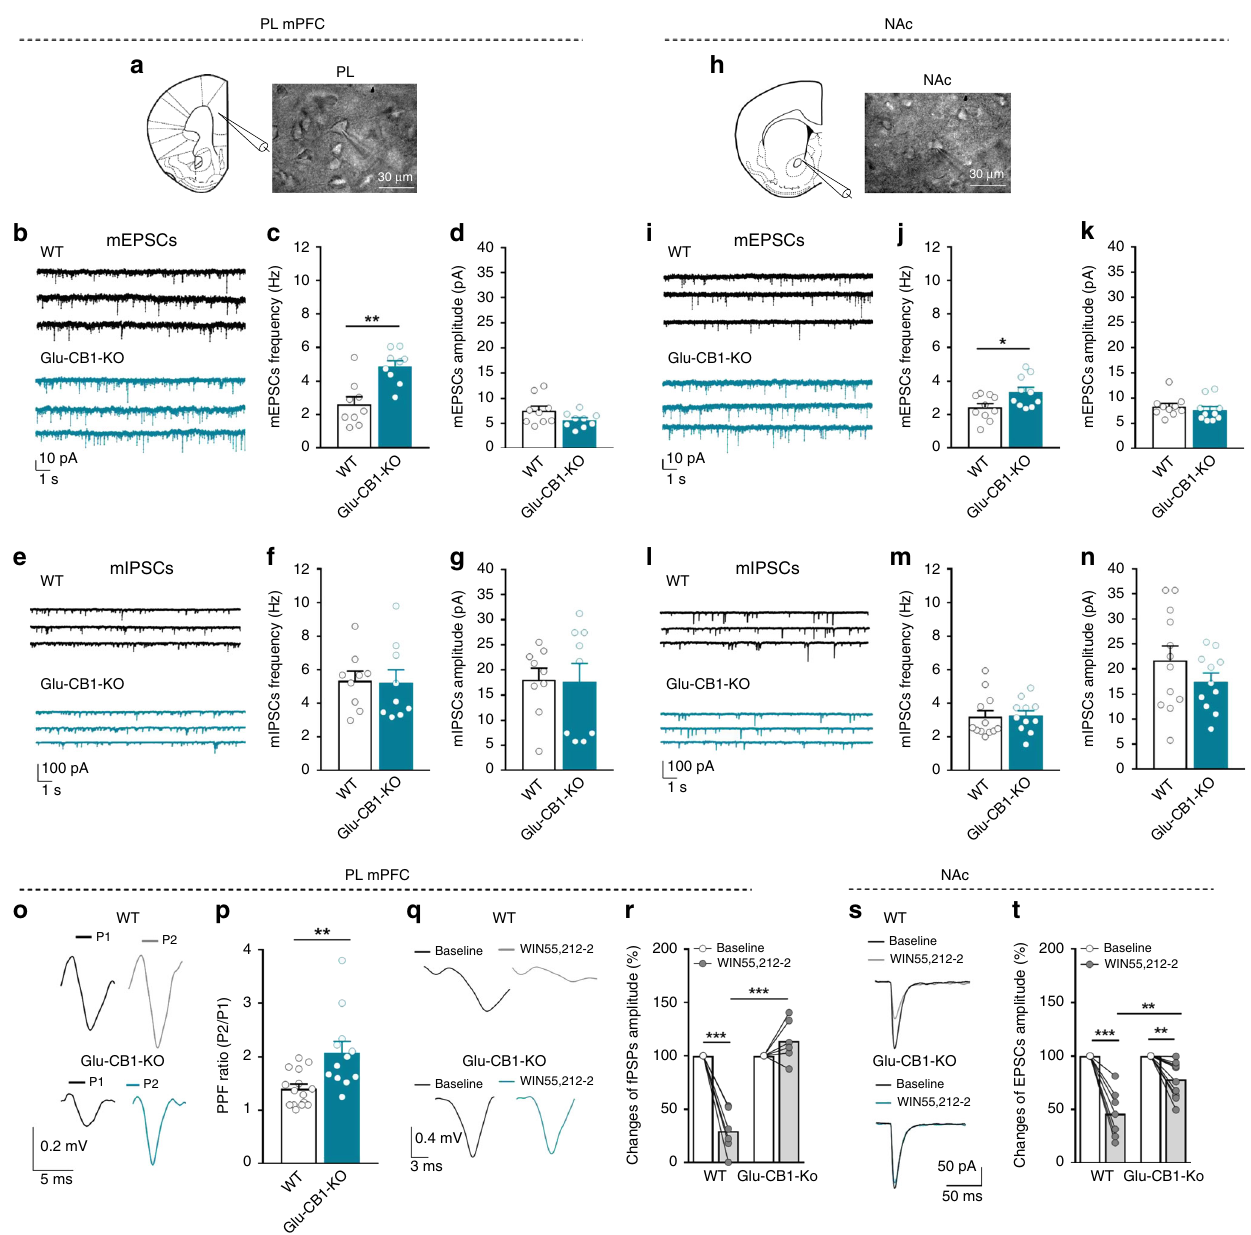
Fig. 2 Synaptic excitatory transmission is increased in Glu-CB1-KO. a, h Schematic drawings and infrared differential interference contrast images showing the recorded neuron in the a PL and h NAc. Scale bars, 30 µ m. b , e Representative traces of miniature excitatory and inhibitory postsynaptic currents (mEPSCs, mIPSCs) recorded at a holding potential of − 70mV in PL and i , l − 75mV in NAc from WT (black traces) and Glu-CB1-KO (blue traces) mice. c , d mEPSCs frequency and amplitude and f , g mIPSCs frequency and amplitude of WT and Glu-CB1-KO mice in the PL and j , k , m , n in the NAc (mean±S.E.M; t -test, * P < 0.05, ** P <0.01, n = 9 – 12 cells from n = 12 mice). o – p Paired pulse facilitation (PPF). o Representative recordings of L5 fi eld postsynaptic potentials (fPSPs) before (P1) and after (P2) stimulating twice in layer 2/3 with an interpulse interval of 50ms for WT (above) and Glu-CB1-KO (below). p Increased paired-pulse facilitation ratio (P2/P1) in Glu-CB1-KO compared to WT (mean±S.E.M, U Mann – Whitney, ** P <0.01; n = 12 – 14 slices from n = 5 animals per genotype). q Representative recordings of the modulation of fPSPs amplitude before and after application of the CB 1 R agonist WIN55,212-2 (5 µ M) compared to baseline in PL for WT (above) and Glu-CB1-KO (below). r Changes of fPSPs amplitude in percentage in PL for WT and Glu-CB1-KO (mean and individual values, paired t -test, *** P <0.001; n = 6 slices from n = 3 animals per genotype). s Representative synaptic responses showing mean EPSCs ( fi ve consecutive EPSCs) before and after CB 1 R agonist WIN55,212-2 (5 µ M) bath application in the NAc for WT (above) and Glu-CB1-KO (below). t Average relative changes of EPSCs amplitude in NAc of WT and Glu-CB1-KO mice (mean and individual values, paired t -test, ** P <0.01, *** P <0.001; n = 7 – 10 cells from n = 4 animals per genotype; see also Supplementary Fig. 3; statistical details are included in Supplementary Table